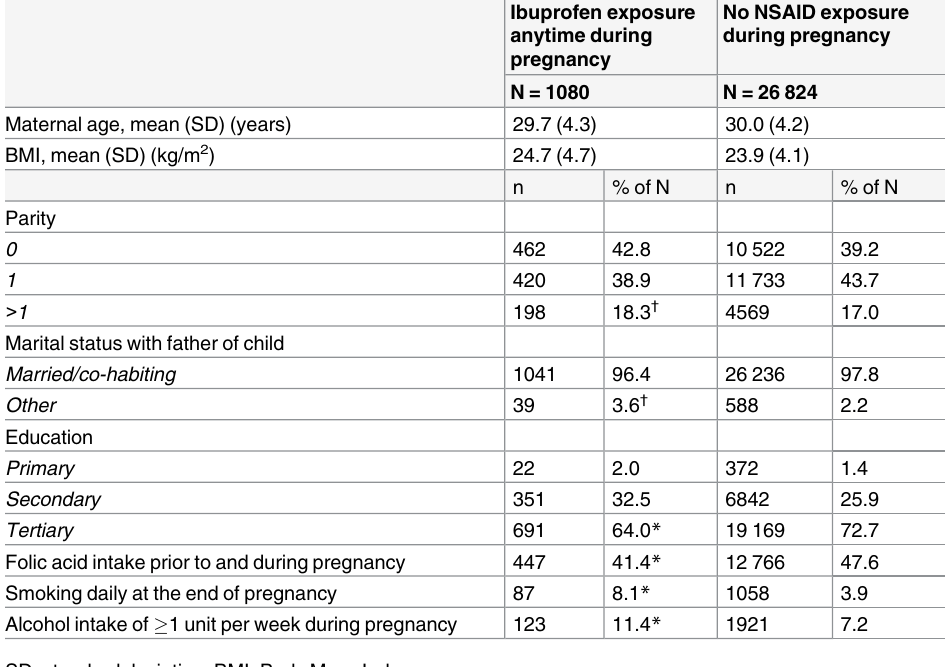
Table 1. Socio-demographic characteristics of the exposed and the unexposed